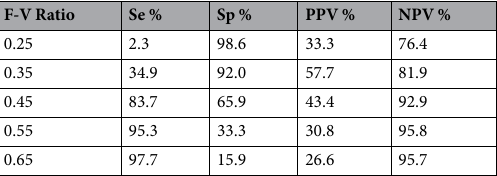
Table 4. The Different Cut-off Points of F-V Ratio in Predicting Hemorrhagic Stroke in Patients with MMD or MMS. F-V Ratio: the ratio of CFCT to CVCT; Se: sensitivity; Sp: specificity; PPV: positive predictive value; NPV: negative predictive